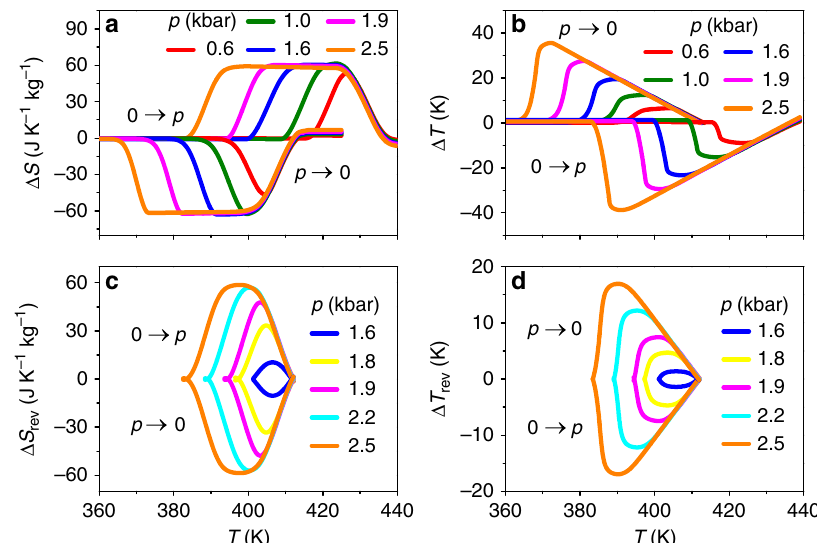
Fig. 3 Giant inverse BC effects in AgI. a , c Isothermal entropy change Δ S and b , d adiabatic temperature change Δ T for applying and removing pressure p , under a , b irreversible and c , d reversible conditions. Data for p = 2.5 kbar deduced from Fig. 1b, data for other pressures deduced from analogous constructions